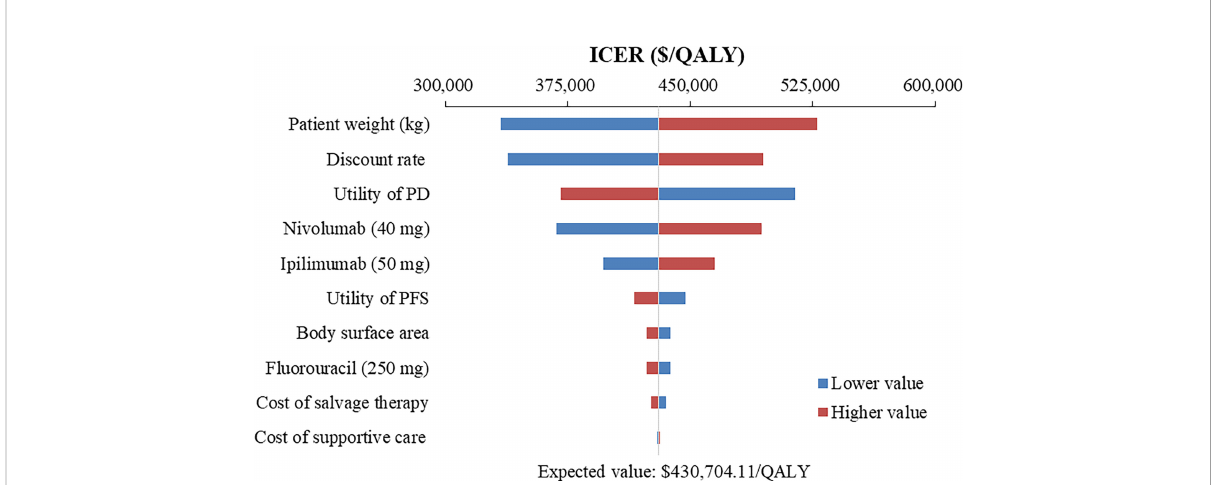
FIGURE 2 Tornado diagram of one-way sensitivity analysis of Nivolumab plus ipilimumab versus Chemotherapy in the treatment of overall advanced ESCC patients. ICER, incremental cost-effectiveness ratio; QALY, quality-adjusted life year; PFS, progression-free survival; PD, progressive